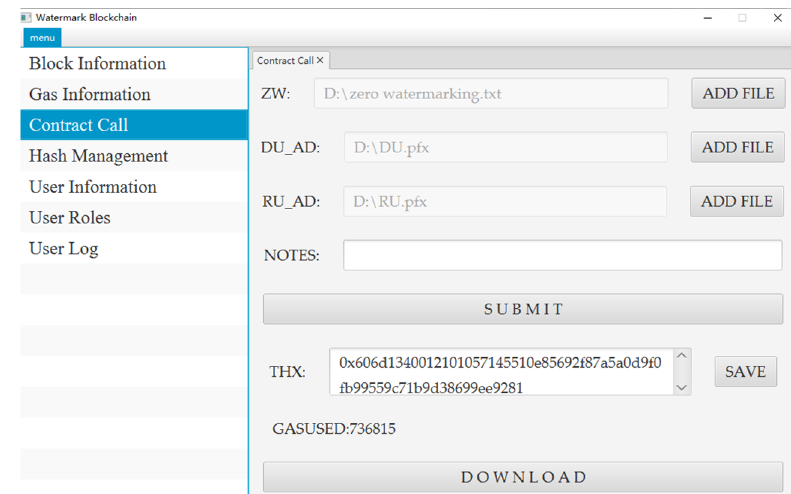
Figure 11. Gas consumption in one transaction.